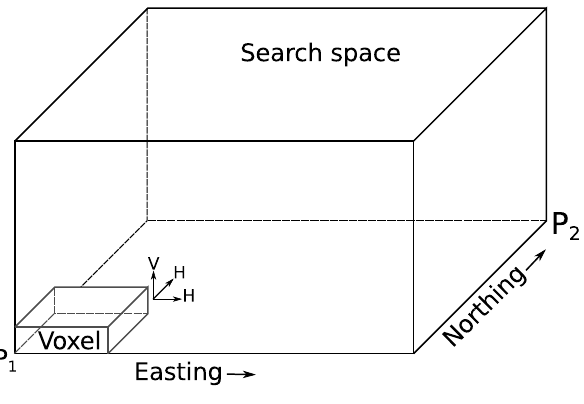
Figure 4. Illustration of the search space and the horizontal (marked with a H) and vertical (marked with a V) voxel